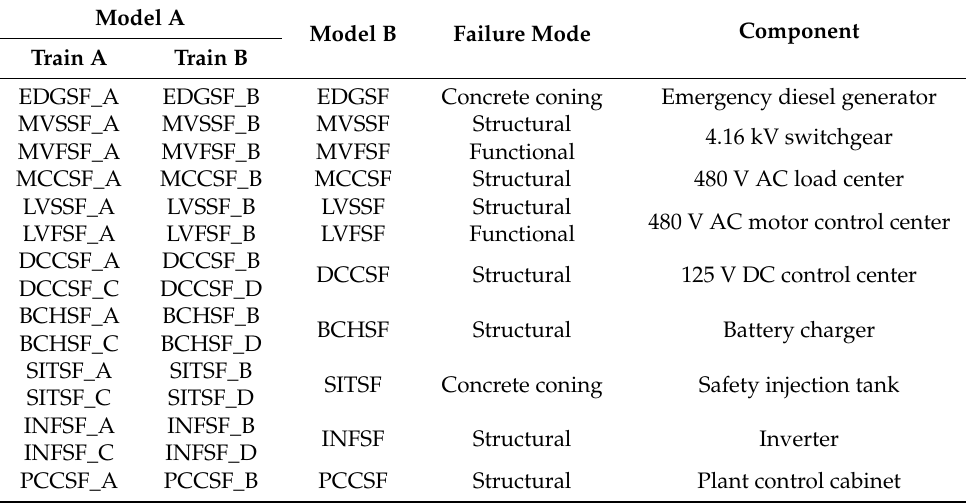
Figure 9. SUCDF fault tree simplified by the full correlation assumption (Model B). Table 3. Seismic failures of redundant/identical components in seismic